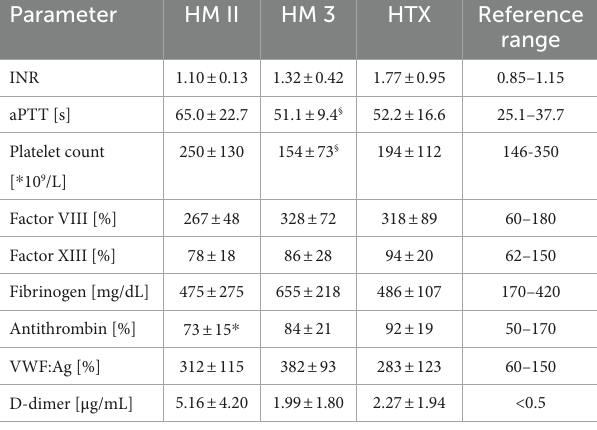
TABLE 1 Routine coagulation of HM II ( n = 16), HM 3 ( n = 20), and HTX patients ( n = 13) postoperatively.